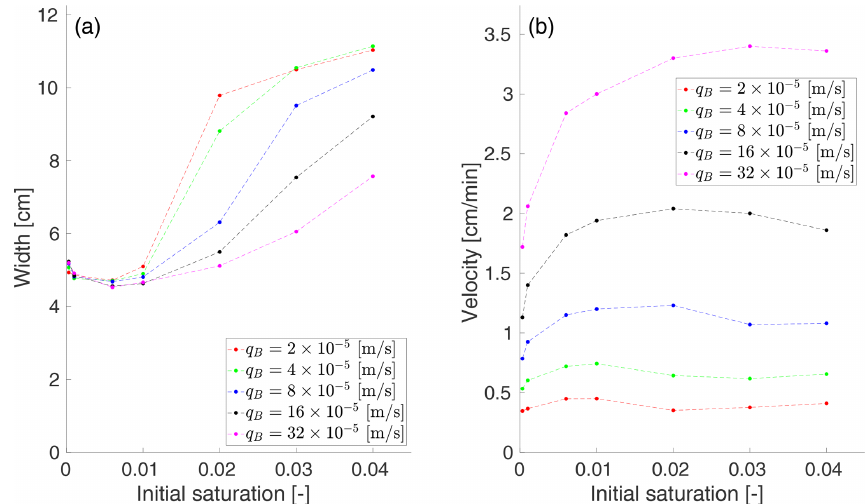
Figure 8. The effect of the boundary flux on the flow regime. The width (a) and the velocity (b) of the finger (or wetting front) is plotted against the initial saturation for five different values of boundary flux q B . Times are scaled according to the boundary flux q B , thus the width and velocity of the moisture profiles are calculated at t = 100 , 50 , 25 , 12 . 5, and 6 . 25min for q B = 2 , 4 , 8 , 16 , and 32 × 10 − 5 ms − 1 , respectively. The averages of four different distributions of the intrinsic permeability are